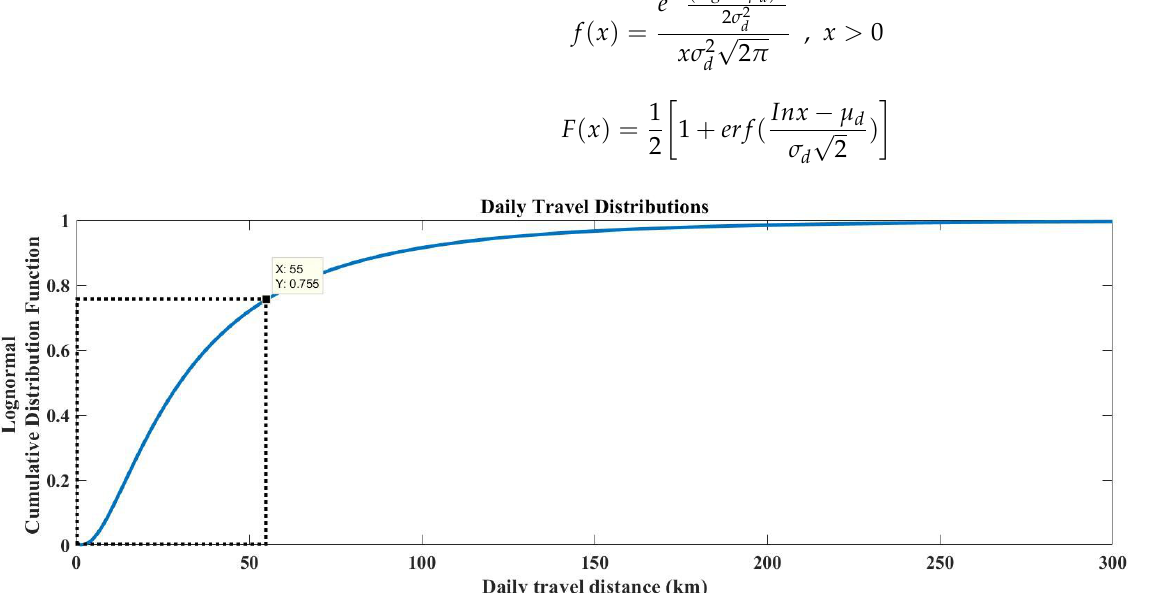
Figure 4. Cumulative distribution of Daily traveling